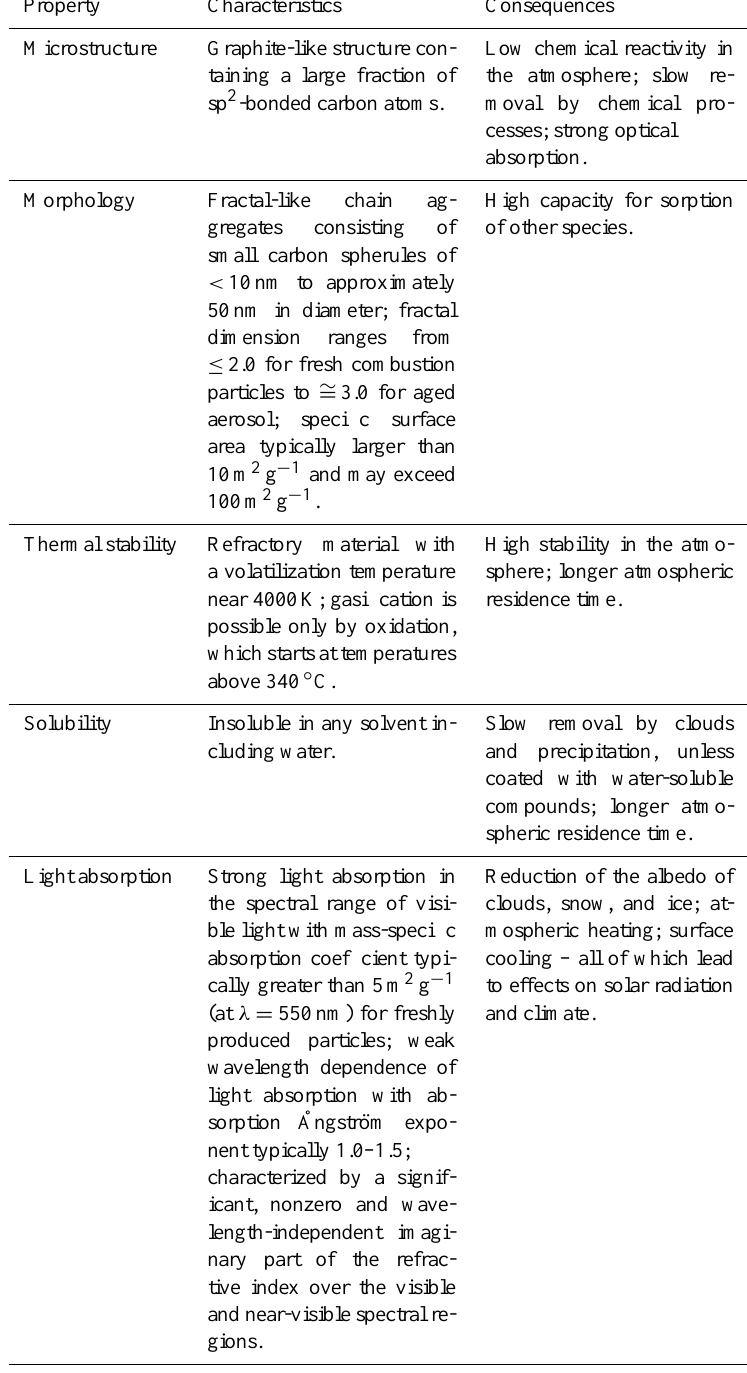
Table 1. Properties defining black carbon and their consequences for effects and